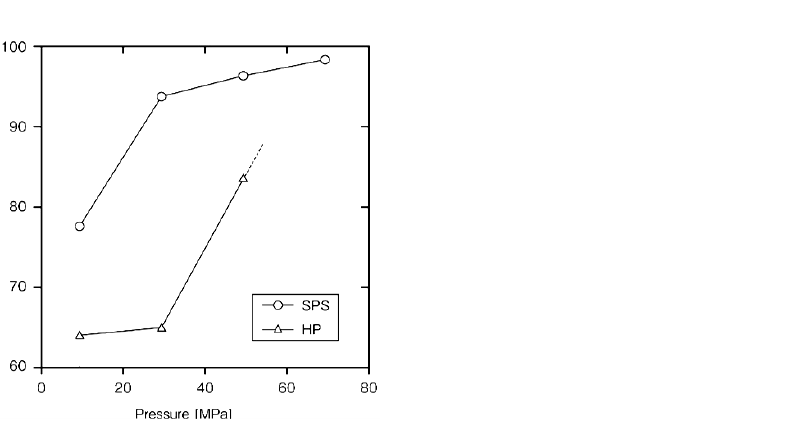
Figure 20. Dependence of Vickers hardness on the sintering temperature in the SPS- and HP-consolidated SiCs.